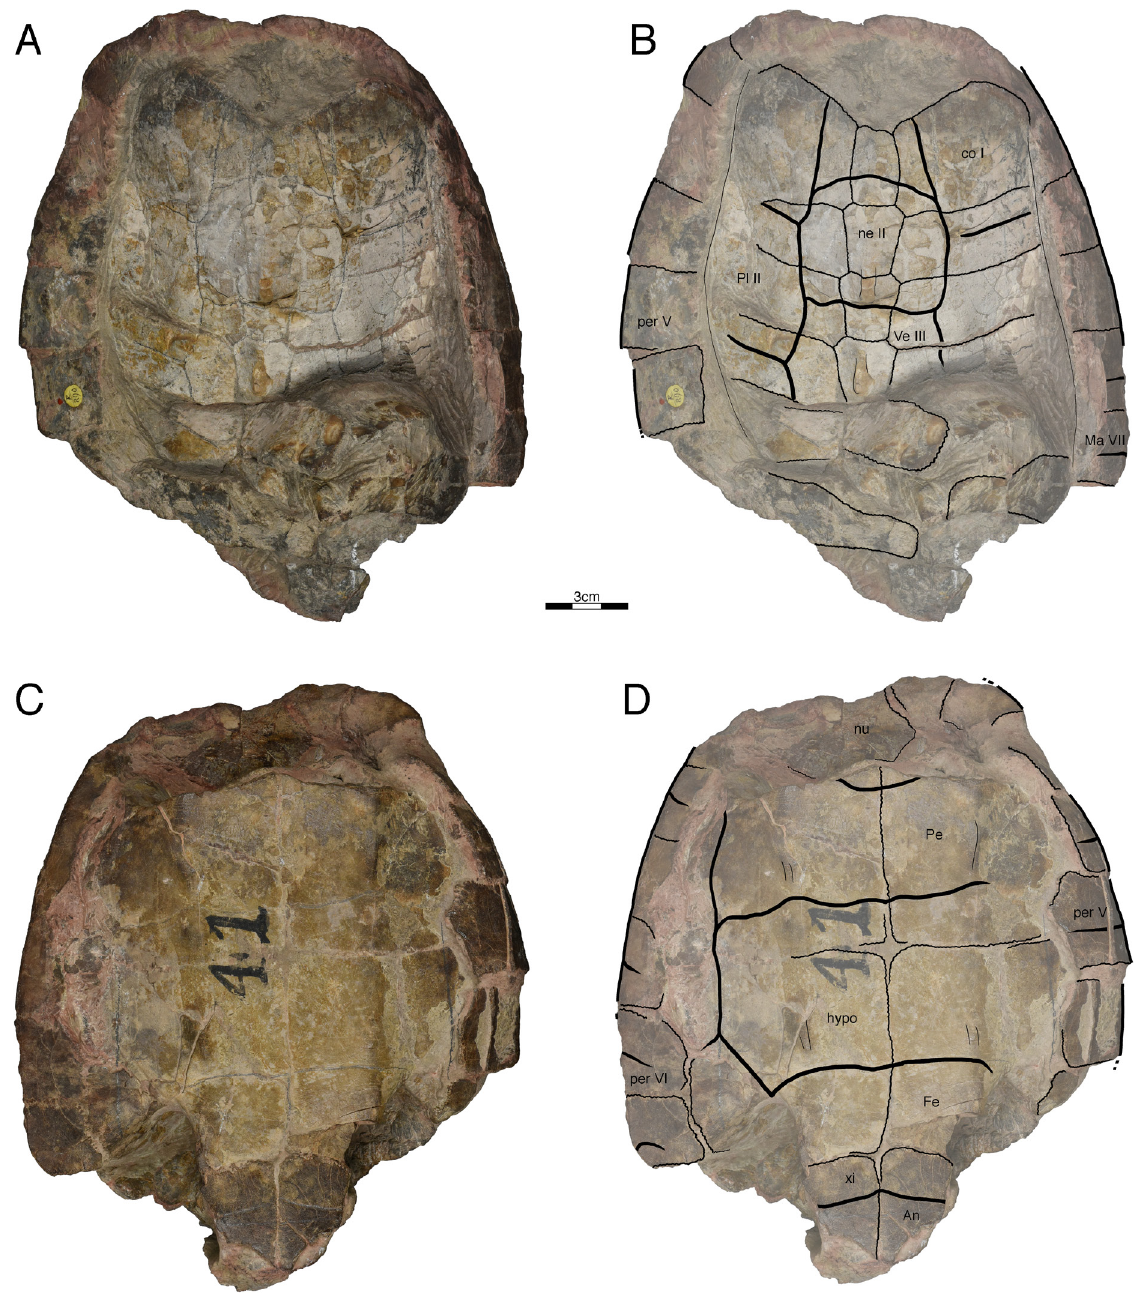
Fig. 21. BMNH R.890, referred to Hardella thurgi (Gray, 1831) by Lydekker (1889b), here identified as Hardella thurjii (Gray, 1831). A . Photograph of carapace. B . Illustration of carapace. C . Photograph of plastron. D . Illustration of plastron. Scale bar: 3